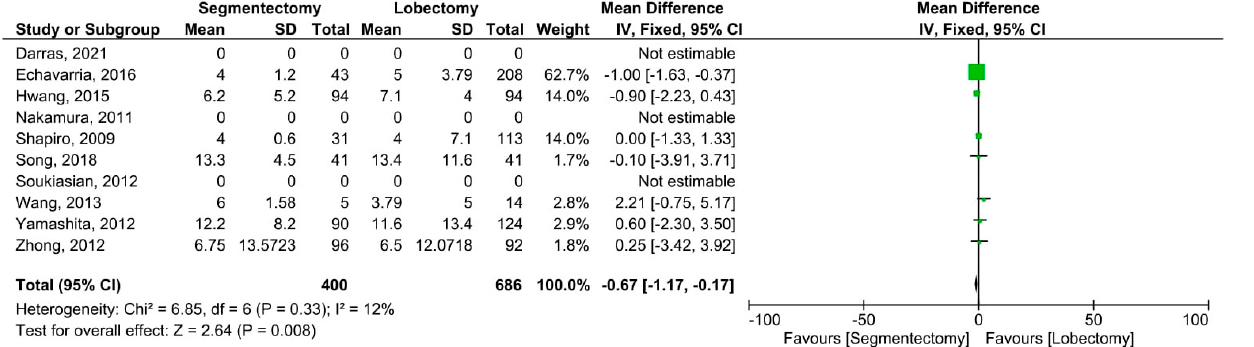
Figure 6. Forest plot for disease ‐ free survival of the minimally invasive segmentectomy and lobec ‐ tomy. CI = confidence interval; dF = degree of freedom; IV = inverse variance; SD = standard devia ‐ tion [8,12–20].